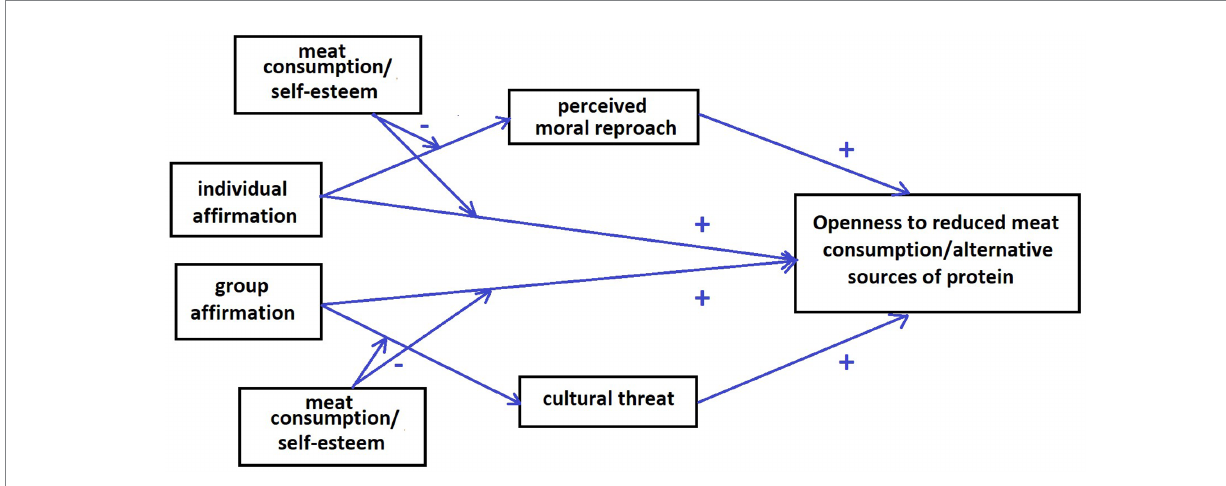
FIGURE 1 The theoretical model: The moderators and mediators of the effect of self-affirmation on the openness to meat reduction/alternative protein